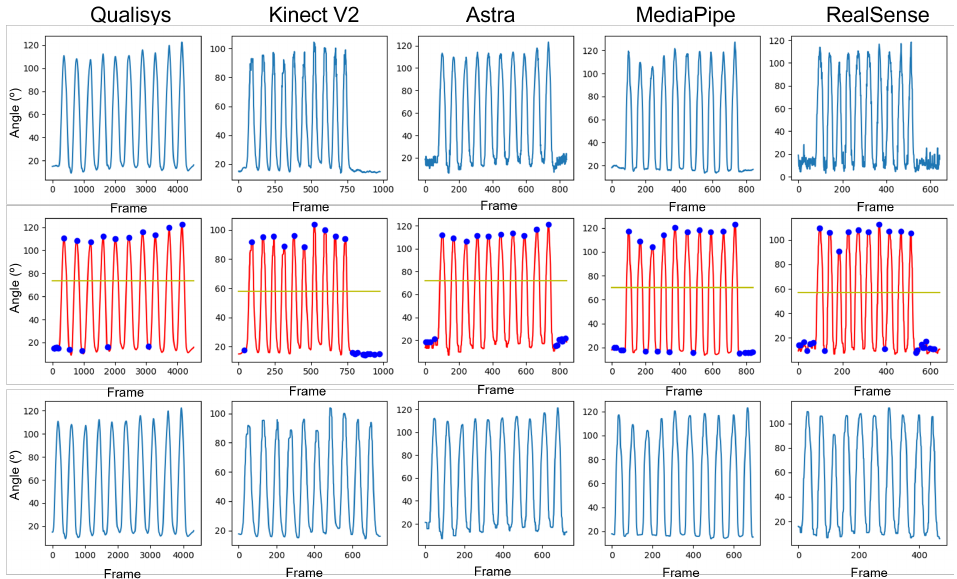
Figure 6. Graphs of the data treatment process. First row contains the pure data without any kind of treatment. Second row represents the data after filtering with the moving average and Butterworth filters. Third row contains data with only the motion